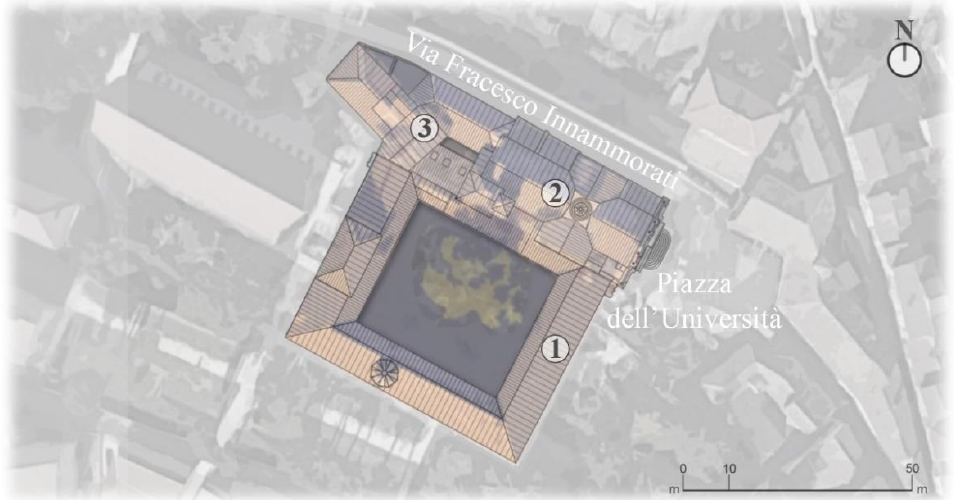
Figure 2. Plan of the architectural complex: (1) Murena Palace; (2) University Church; (3) Ex-Accountancy Office.